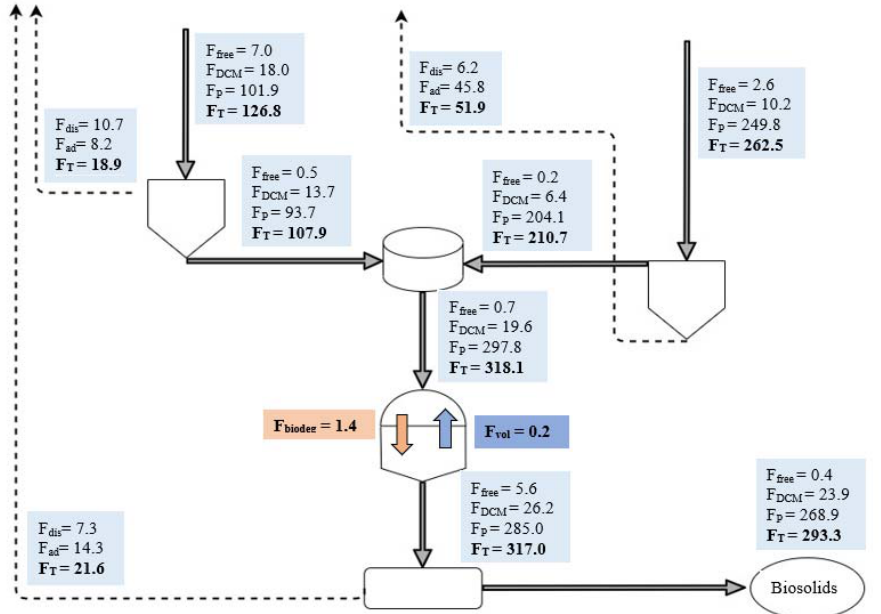
Figure 5. Fate of naphthalene in the sludge line. Results are presented in g/day. F dis is the resulting load in the dissolved phase, F free is the freely dissolved, F DCM is sorbed to the dissolved and colloidal matter (DCM), and F p is sorbed to particles.